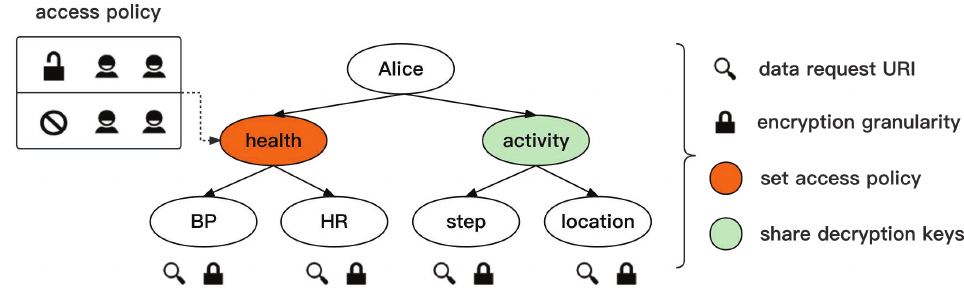
Figure 2. NACDA’s design